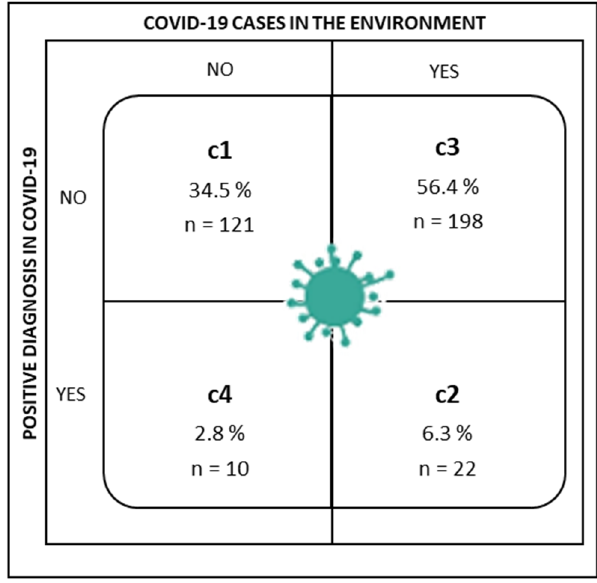
Figure 2. Distribution of the sample by COVID-19 scenarios.